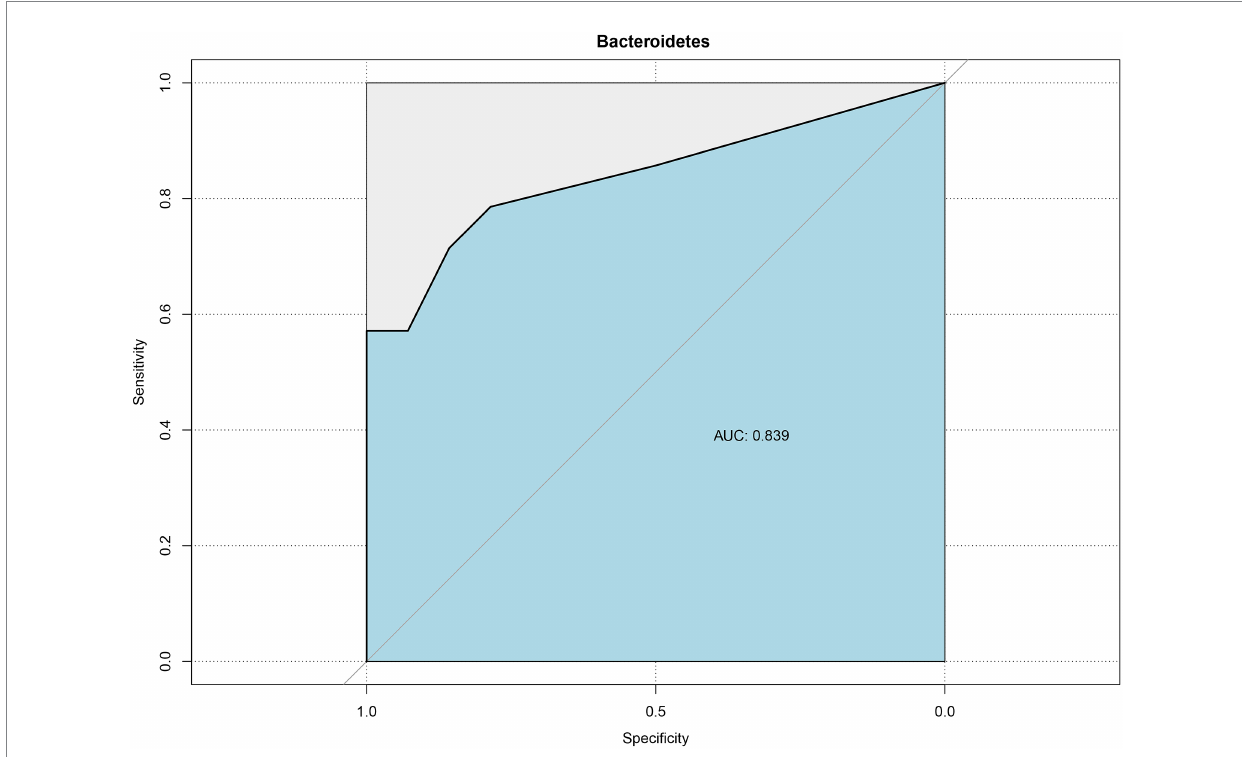
FIGURE 6 ROC curve of Bacteroidetes for distinguishing pathologic jaundice.